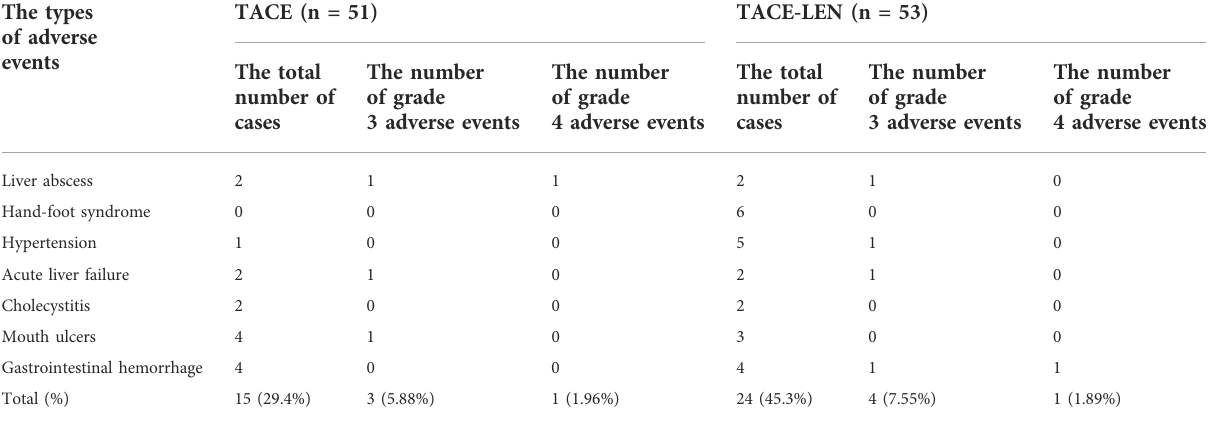
TABLE 5 Comparison of adverse events after treatment between the two